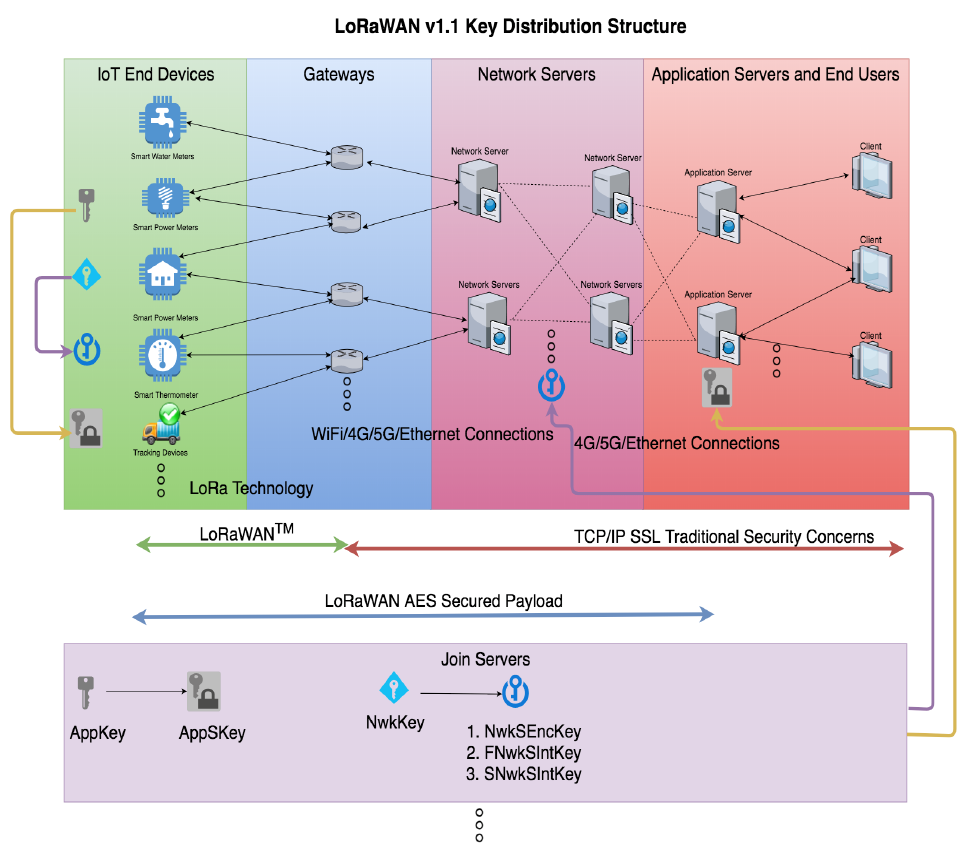
Figure 2. LoRaWAN v1.1 Key Distribution